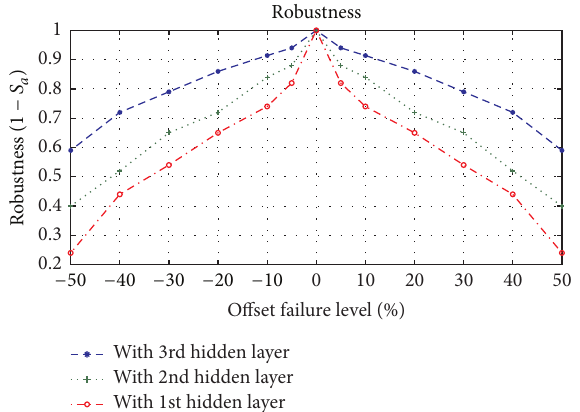
Figure 8: Robustness measure (1 − autosensitivity) at multiple hidden layers in DAASM. Higher curves depict high robustness.